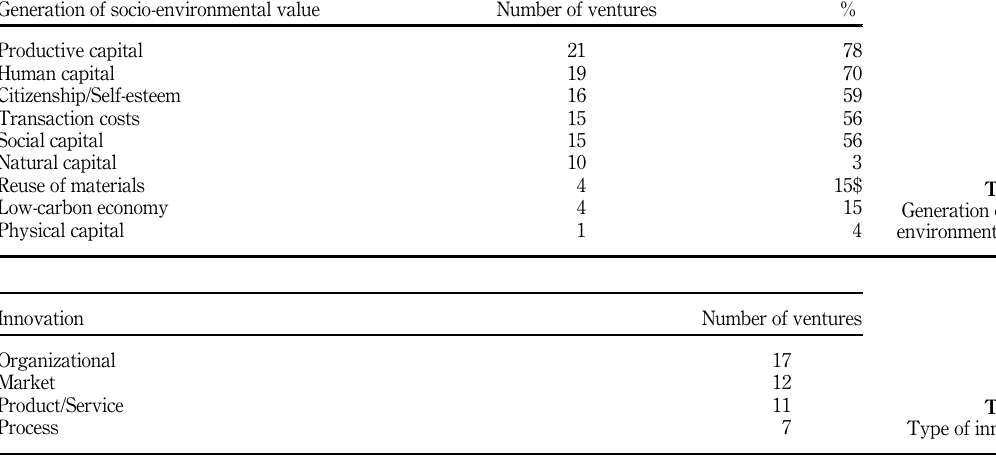
Table 2. Generation of socio-